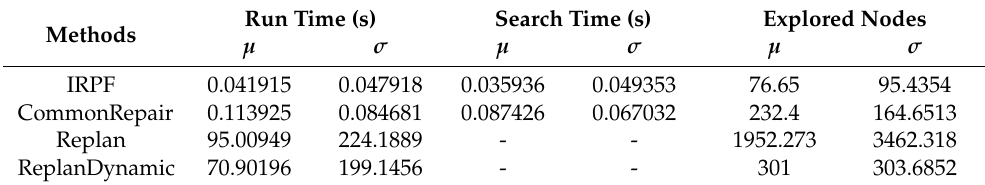
Figure 5. Comparison of test results of different methods in the rover system, including ( a ) run time, ( b ) search time, ( c ) number of explored nodes. Table 2. Summary of statistics for the performance of different methods in the multi-rover system.